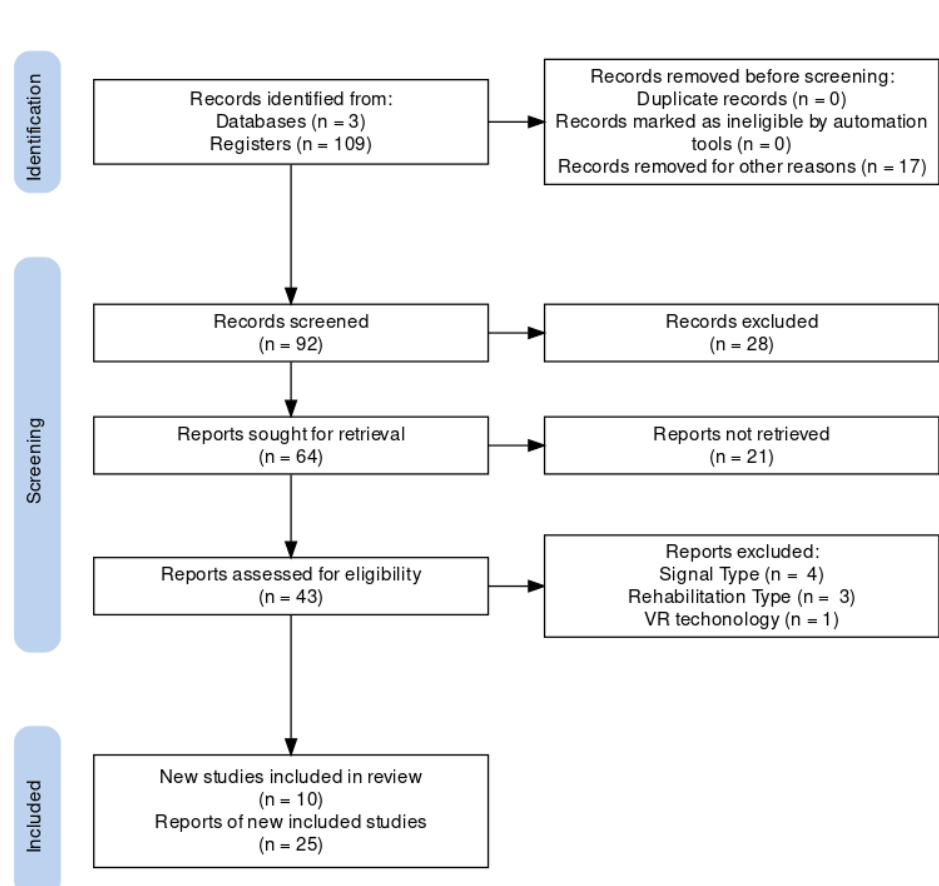
Figure 2. PRISMA diagram of the present work. Figure 3 represents the number of publications under the BCI topic over the last 20 years, which could bring information about the growth of the number of publications that alludes to this topic.